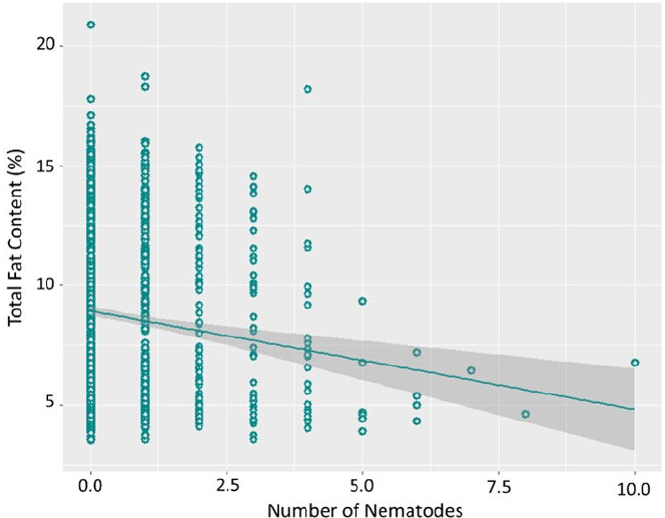
Figure 5. Correlation between total fat content (%) and the number of nematodes infecting sardines on the Catalan Coast.